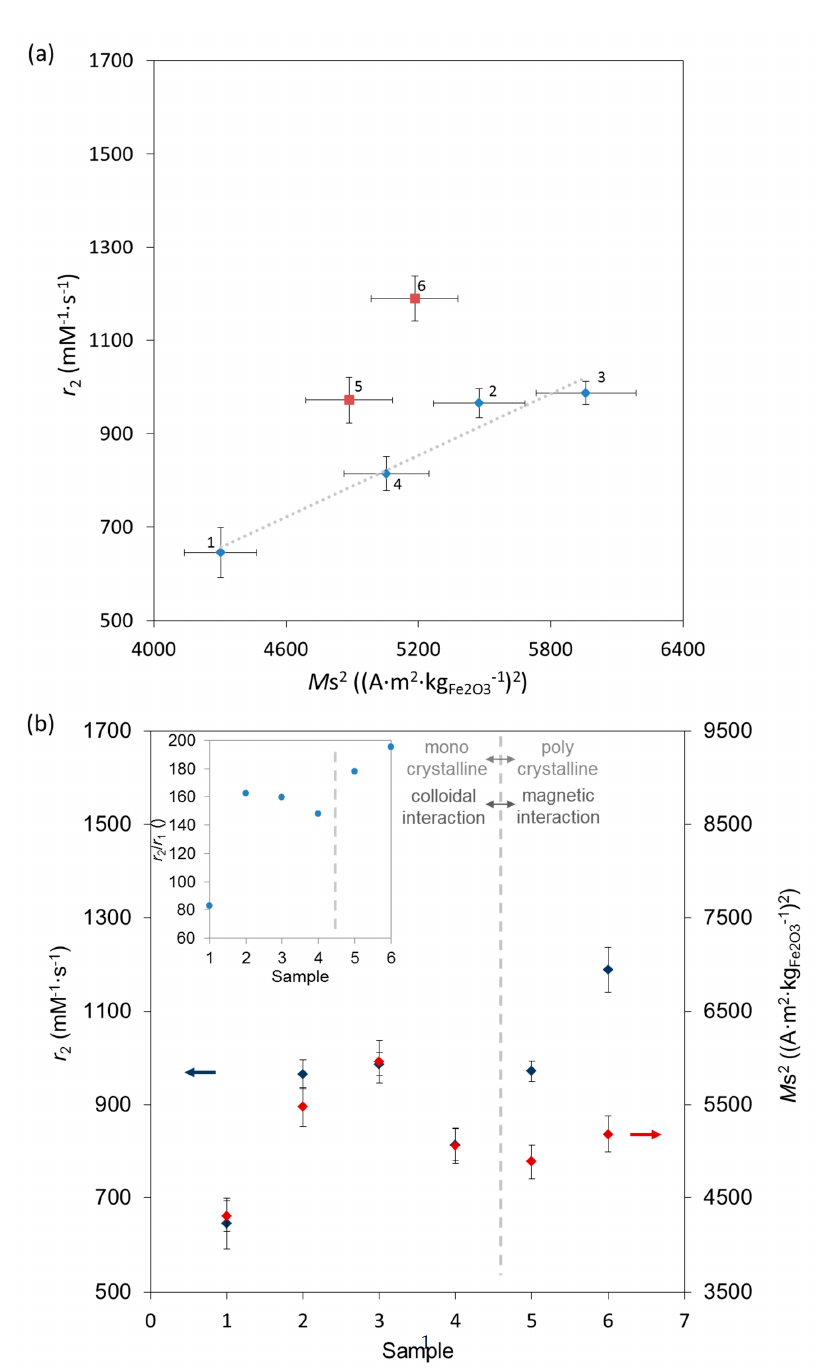
Figure 5. ( a ) MRI transverse relaxivity ( r 2 ) as a function of square of corresponding saturation magnetization ( M s ) shows increase except for the samples 5 and 6 (marked red); ( b ) r 2 in blue and ( M s ) 2 in red, given versus samples of IONPs along with the increased duration of the HT treatment. Insert shows the relaxivity ratio ( r 2 /r 1 ) versus